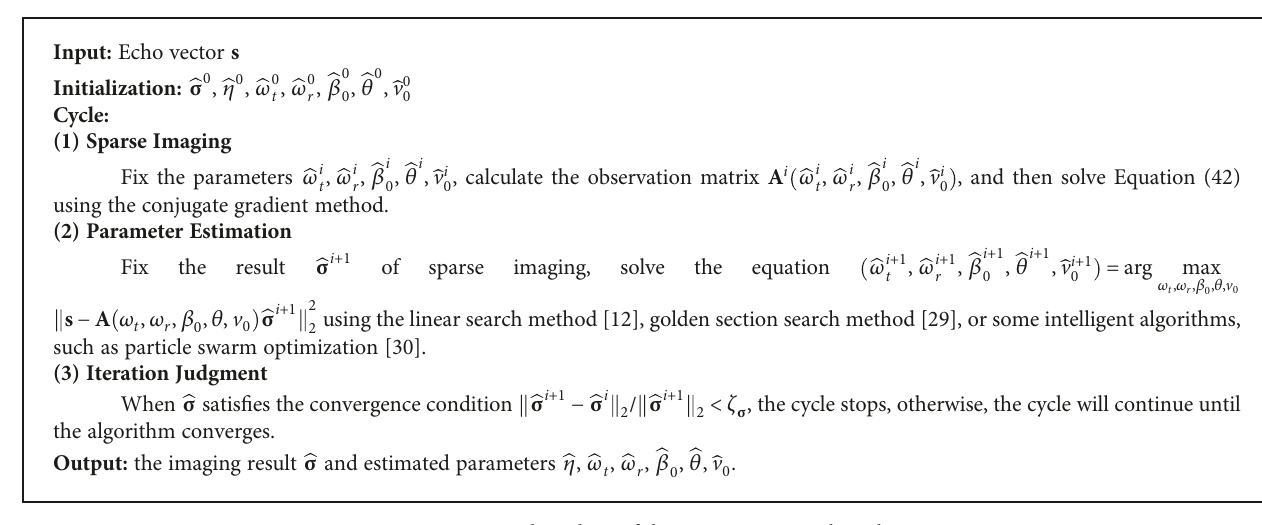
Algorithm 1: Flow chart of the sparse imaging algorithm.